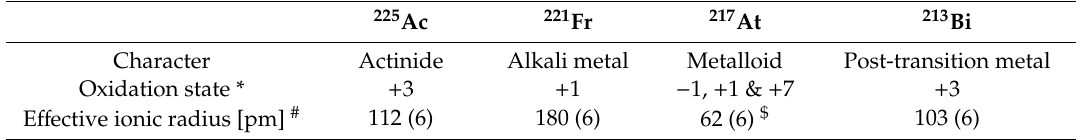
Table 1. Selection of various characteristics demonstrating the striking di ff erences between 225 Ac and its first three progenitors in relation to their diverse coordination preferences.